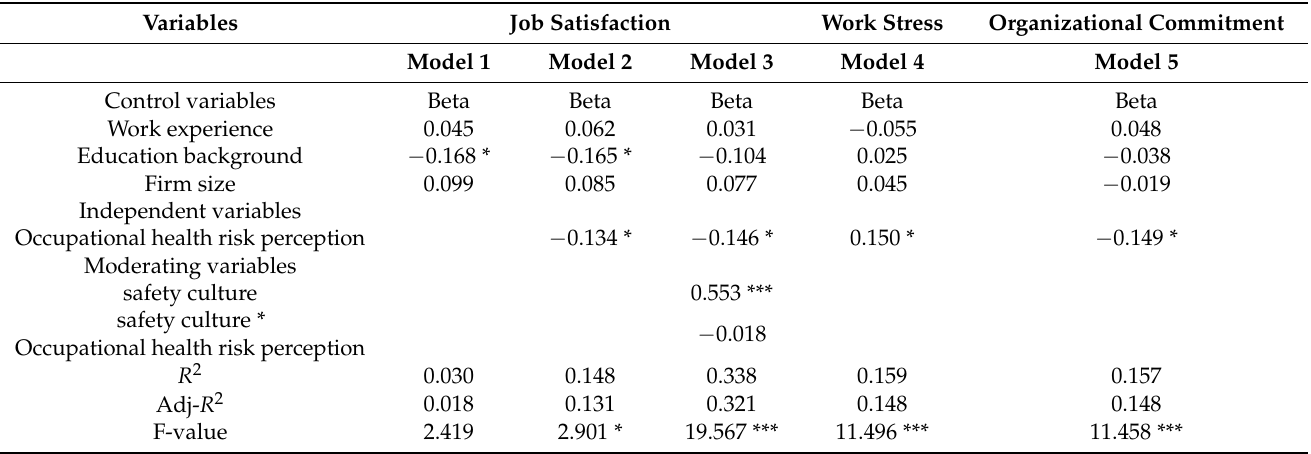
Table 3. The results of the regression analysis (model